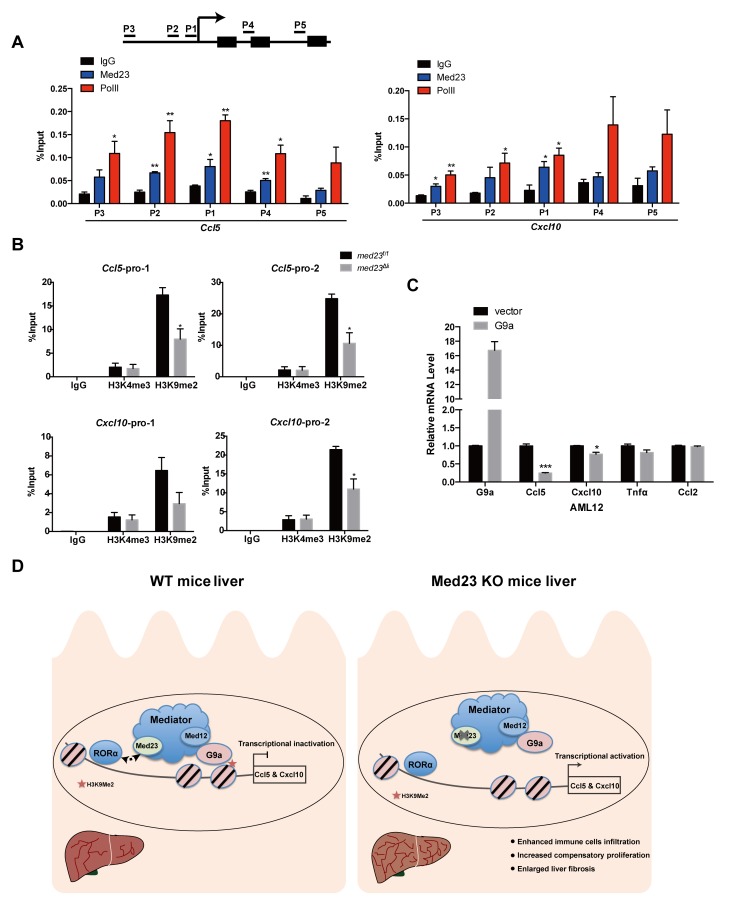
Med23 deletion causes decreased H3K9me2 occupancy among the promoter of Ccl5 and Cxcl10.(A, B) ChIP analysis of MED23 and Pol II occupancy in AML12 cells (n = 3 per group) (A) as well as H3K4me3 and H3K9me2 occupancy in med23f/f and med23Δli mouse livers after acute administration of CCl4 (med23f/f, n = 3; med23Δli, n = 4) (B). IgG was used as a negative control. The precipitated DNA was analyzed by qRT-PCR with primers targeting the promoter regions of Ccl5 and Cxcl10. The relative binding level of each factor was calculated by normalization to the input DNA. (C) qRT-PCR analysis of proinflammatory cytokines and chemokines in AML12 cells after G9a transient transfection (n = 3 per group). (D) A proposed model for the role of MED23 in hepatocyte after CCl4 challenge. MED23 modulates RORα transcriptional activity possibly via G9a-mediated H3K9me2 modification to the target promoters for transcriptional repression. Data are presented as means ± SEM. *P < 0.05, **P < 0.01, ***P < 0.001. For underlying data, see S1 Data file. AML12, alpha mouse liver 12; Ccl, C-C motif chemokine ligand; CCl4, carbon tetrachloride; ChIP, chromatin immunoprecipitation; Cxcl, C-X-C motif chemokine ligand; IgG, immunoglobulin G; KO, knockout; MED23, Mediator complex subunit 23; med23Δli, liver-specific knockout of Med23; med23f/f, med23-floxed; Pol II, RNA polymerase II; qRT-PCR, quantitative real-time PCR; RORα, RAR-related orphan receptor alpha; WT, wild-type.